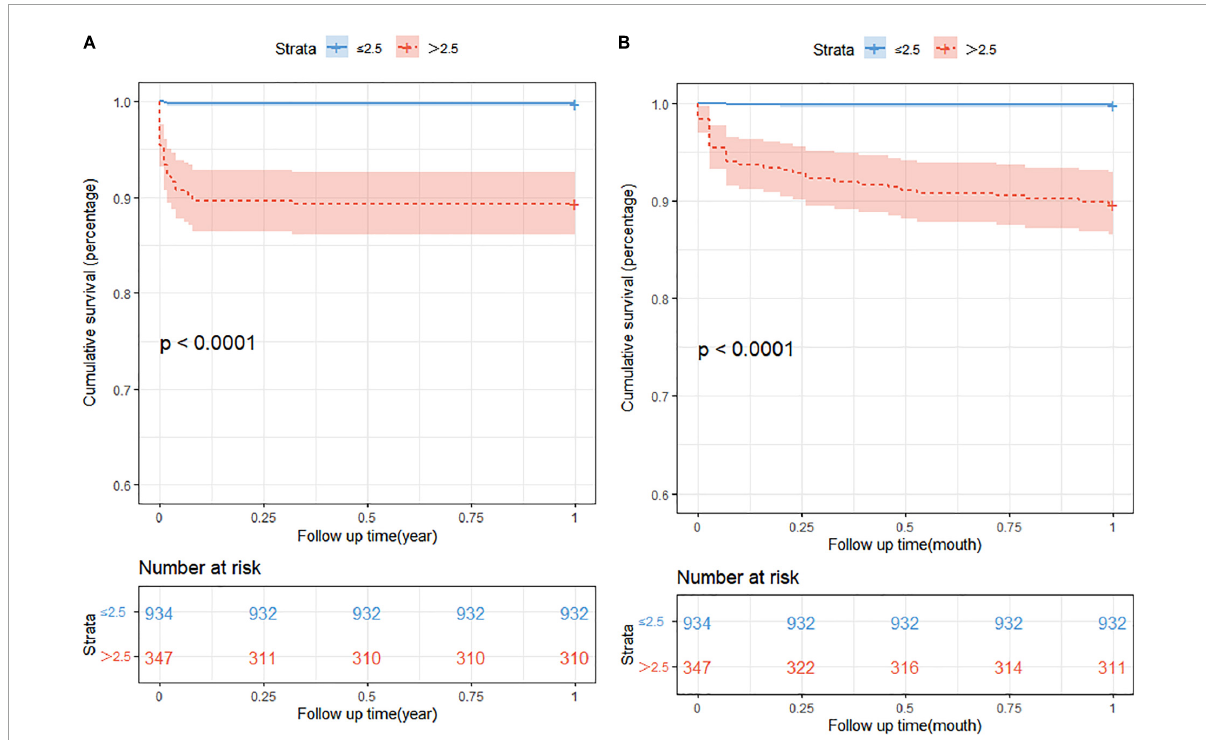
FIGURE2 The Kaplan-Meier survival analysis curves. (A) The 1-year all-cause mortality; (B) 1-month all-cause mortality. nSOFA, neonatal sequential organ failure assessment.